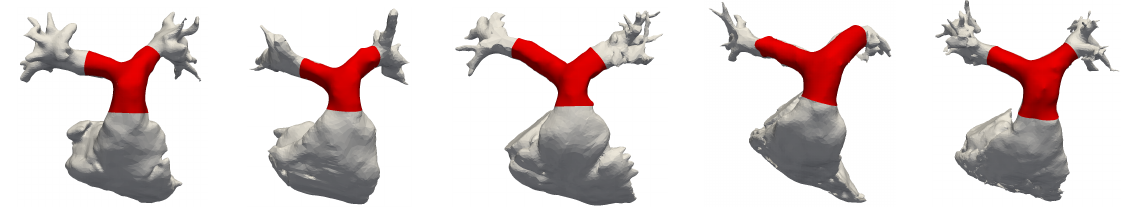
Figure 2. Front view of the five raw segmentations, including the right ventricle (RV) and tracts of the high-order branches. Superimposed in red are the cropped portions used for the derivation of the template. From left to right: subjects #1 to #5. Models are not to